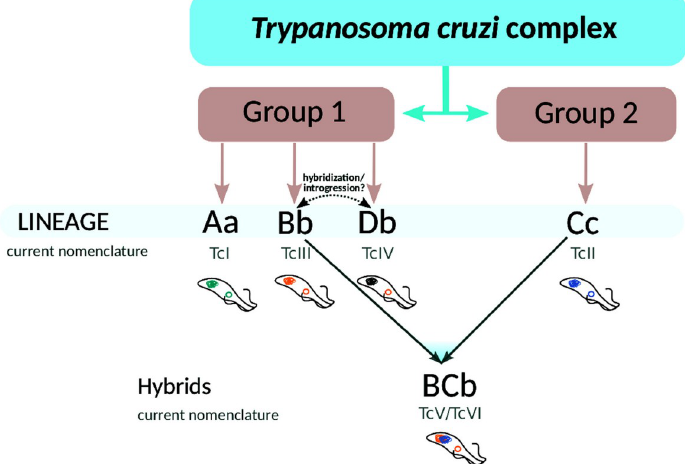
Fig 6. Evolutionary relationships in the Trypanosoma cruzi complex . T . cruzi is composed by two main groups 1 and 2, which does not correspond to the original I and II groups. Group 1 is divided in clades A, B and D, and group 2 contains clade C. Lower cases indicate the maxicircle variant (a, b, and c), and BC refers to hybrid